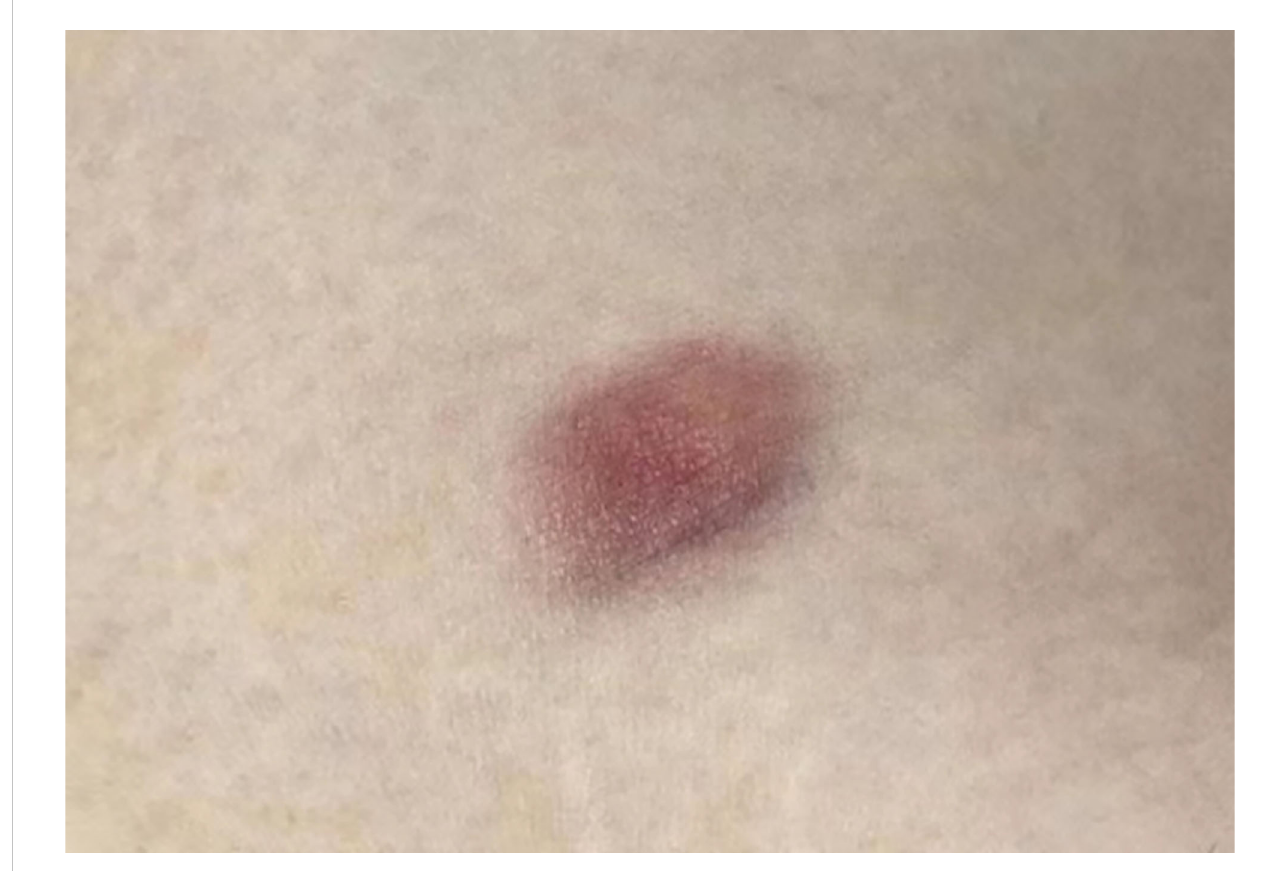
FIGURE 1 A 16×10mm atrophic erythematous plaque on her right